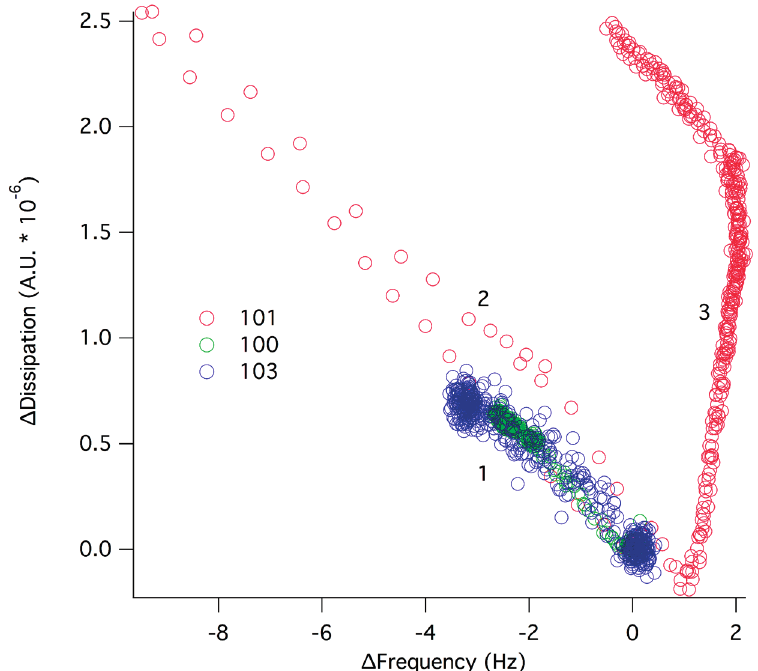
Figure 3. ∆ d plotted as a function of ∆ f for 6 µM of D100 (green), D101 (red) and D103 (blue) interacting with a supported lipid bilayer of POPC. At ∆ d, ∆ f = 0, dendrimers were added to the supported lipid bilayer. A pure adsorption process (1) occurred for all three dendrimers (increase in ∆ d and decrease in ∆ f). For D101, the adsorption was followed by desorption (2) and layer rearrangement